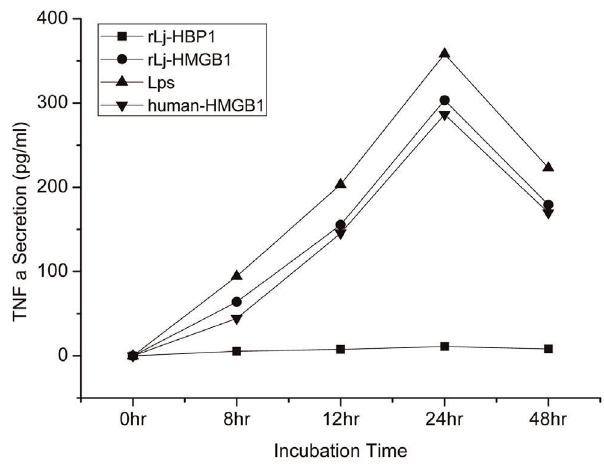
Figure 7. Lamprey HMGB1 induced TNF- a production in THP-1 monocytic cells. THP-1 cells (1 6 10 9 cell/L) were incubated with rLj- HBP1 (50 ng/ml), rLj-HMGB1 (50 ng/ml), LPS (50 ng/ml), or human HMGB1 (50 ng/ml) for various lengths of time. Human HMGB1 was used as a positive control, and rLj-HBP1 was used as a negative control. The concentration of released TNF- a in the culture supernatants was measured by ELISA.